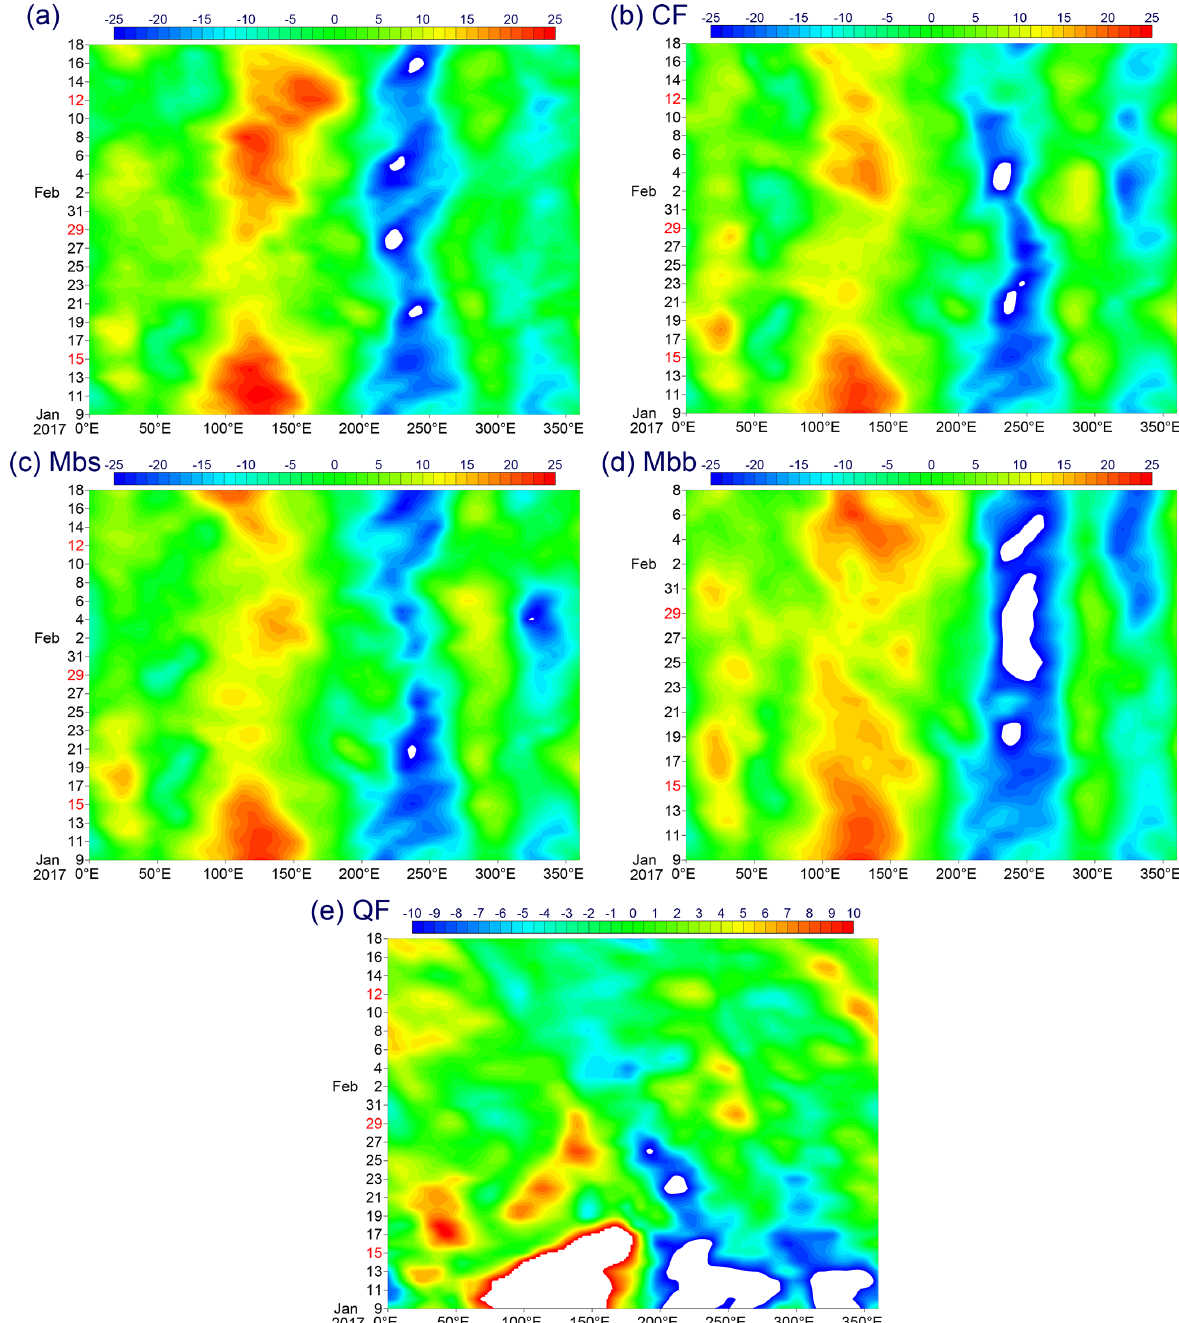
Figure 5. Time–longitude sections averaged over 15 ◦ S–15 ◦ N of the 150hPa level stream function for the 40d extended forecast case: (a) analysis, (b) CF, (c) Mbs, (d) Mbb and (e) QF. Note that the Mbb case (d) is an exception and only runs for